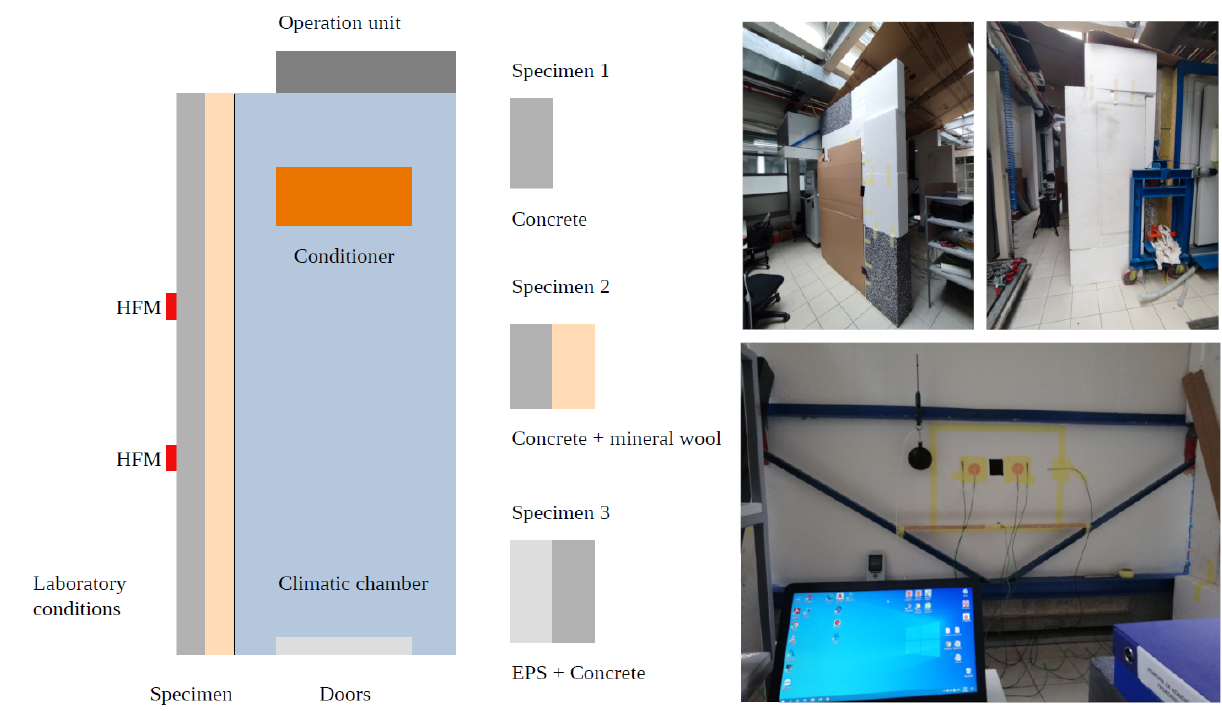
Figure 3. Schematic view of the experimental facility on the ( left ) and experimental setup on the ( right ).